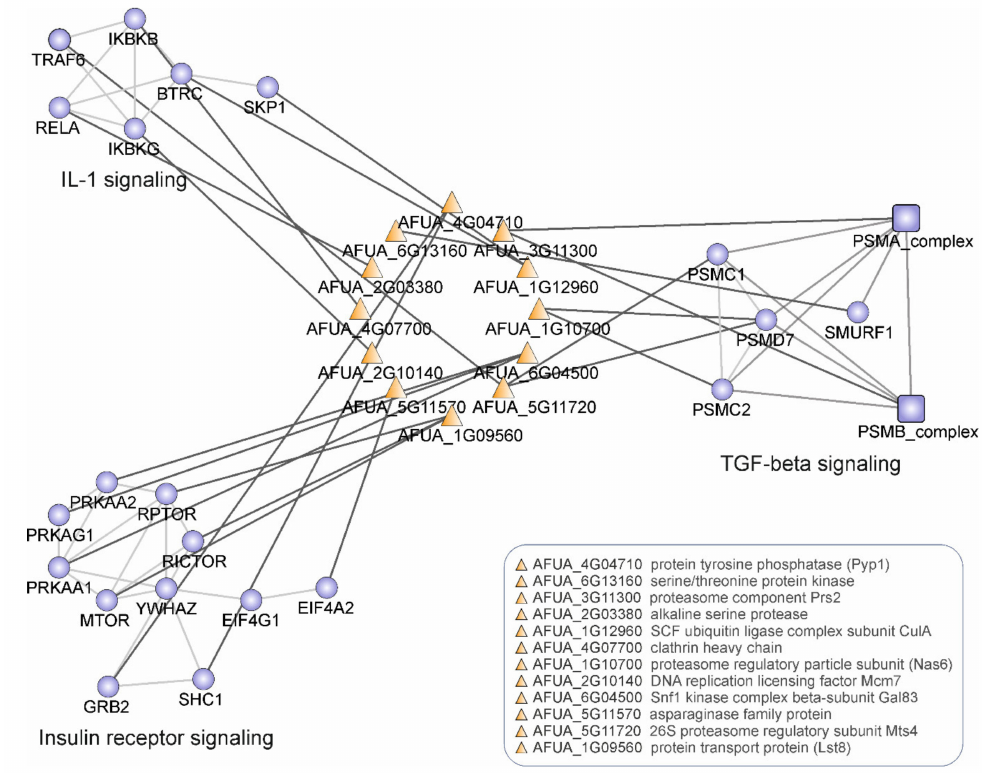
Figure 5. A. fumigatus –human host proteins–protein interactions (PPIs) map. PPIs between A. fumigatus proteins coded by positively selected genes (PSGs) and human proteins involved in three pathways are illustrated: IL1-signaling, Insulin receptor signaling and TGF-beta signaling. Orange— A. fumigatus proteins and blue—human